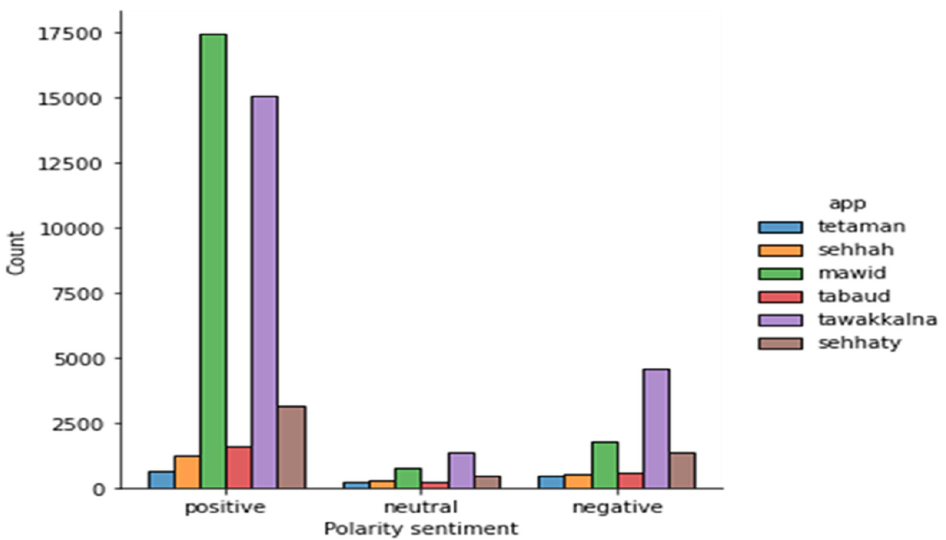
Figure 3. Distribution of sentiment for each app.